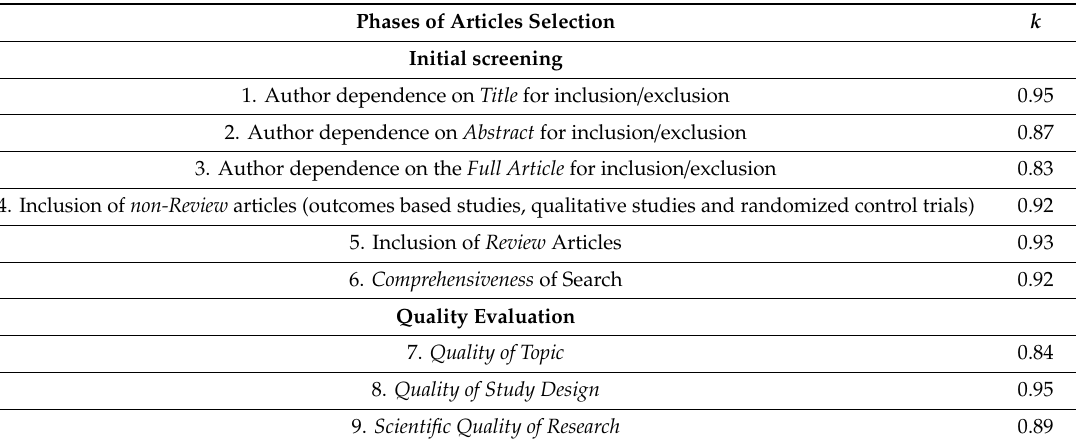
Table 4. Inter-rater Reliability ( K